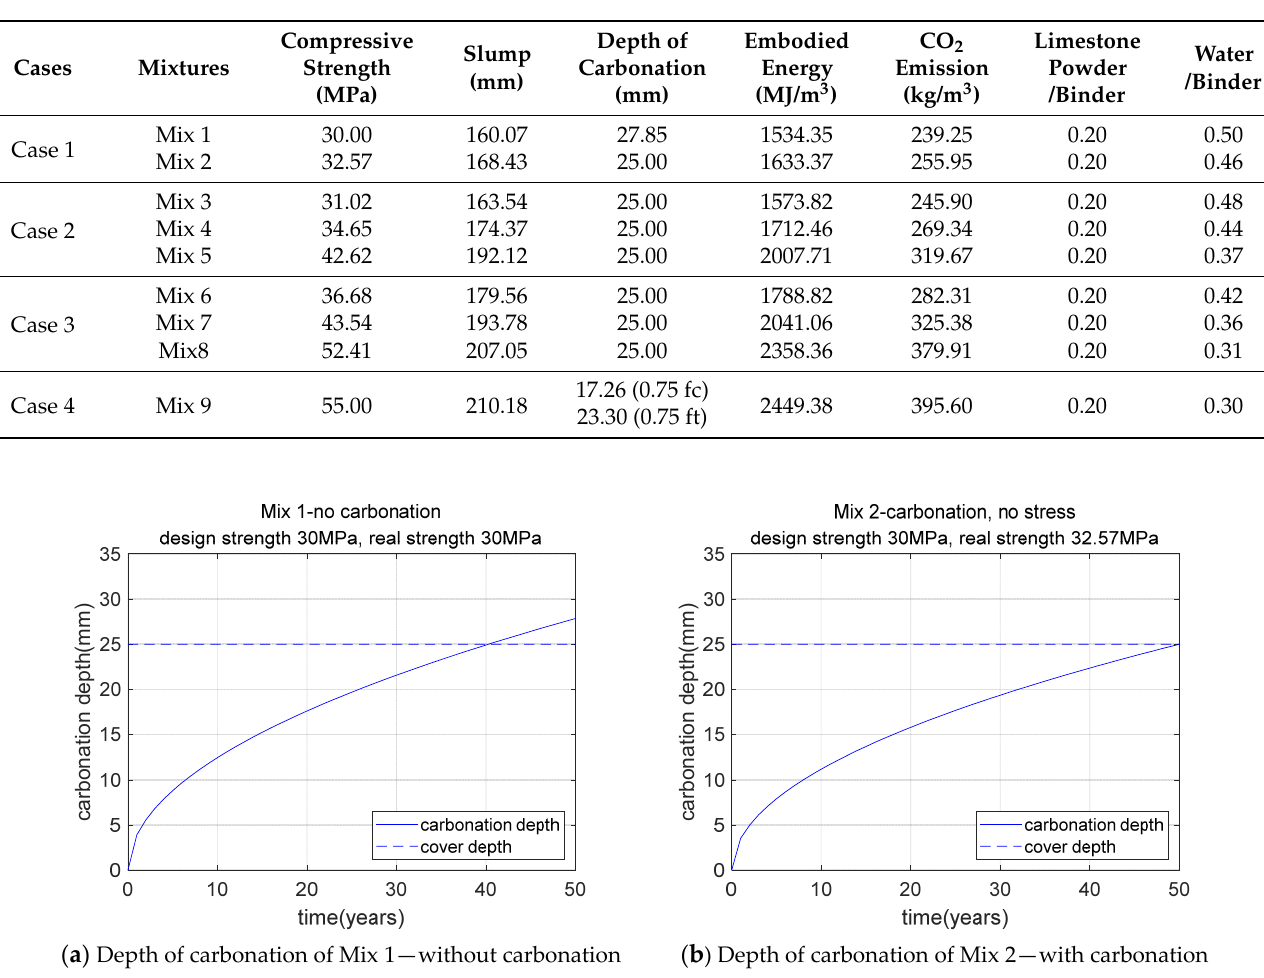
Table 6. Concrete performance of results of case studies.